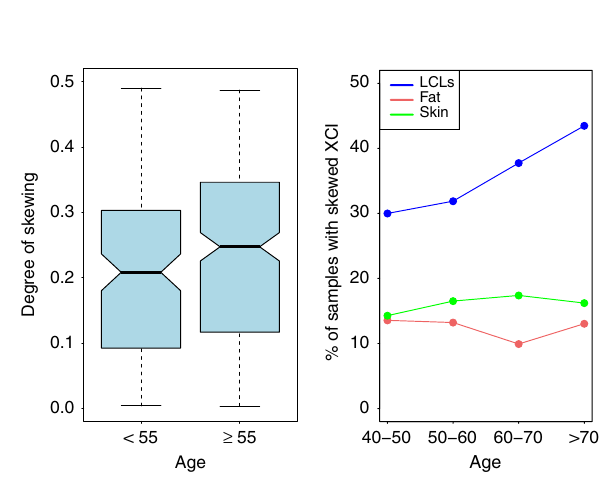
Fig. 4 Skewed XCI increases with age in blood-derived tissues but not in fat or skin tissues. Left panel, boxplots show the degree of skewing in LCLs samples <55 ( n = 141) and ≥ 55 ( n = 281). Median (black line in the middle), fi rst and third quartile (boxplot bounds), and whiskers (dashed lines) are shown. Right panel, line plots show the frequencies of skewed XCI at different ages in LCLs (blue), fat (red) and skin (green) tissues. XCI X-chromosome inactivation.